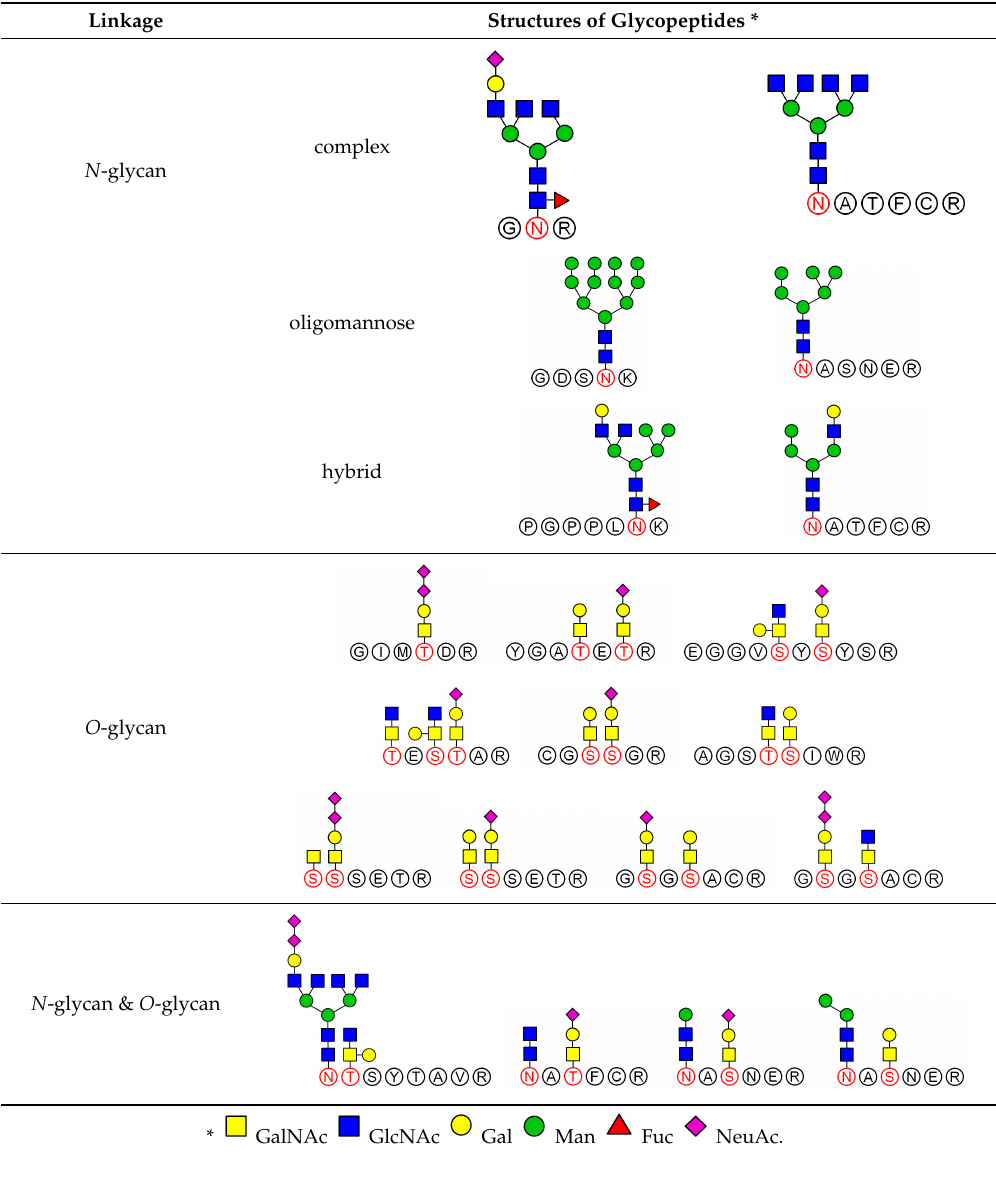
Table 2. Structures of the major glycopeptides from Gg.